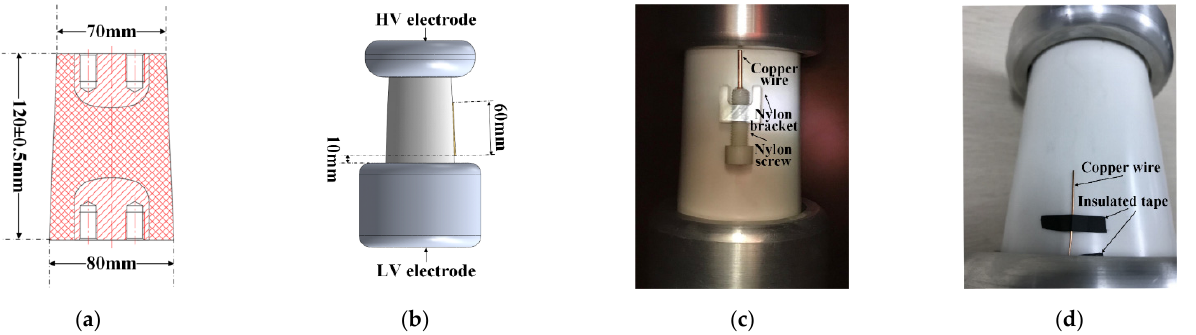
Figure 3. The dimensioning of insulator and the schematic diagrams of No. 4 surface defect, No. 2 floating defect and No. 3 point defect. ( a ) Dimensioning of insulator; ( b ) No. 4 surface defect; ( c ) No. 2 floating defect; ( d ) No. 3 point defect. Table 1. Locations and sizes of four different insulation defects.